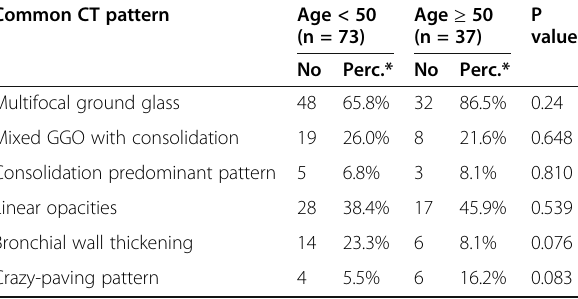
Table 4 The association between common CT pattern with patients ’ age Common CT